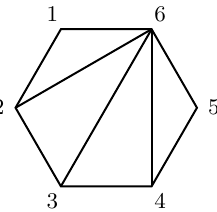
Figure 4. The two-brackets ( ij ) can be identi(cid:12)ed with chords on a hexagon between the vertices i and j . A triangulation of the hexagon then corresponds to a cluster of the A 3 or Conf 6 ( P 3 ) polytope. Above is shown the triangulation corresponding to the initial cluster of (cid:12)gure 2 comprised of the chords (26) = h 1345 i , (36) = h 1245 i and (46) = h 1235 i together with the six edges which correspond to the frozen